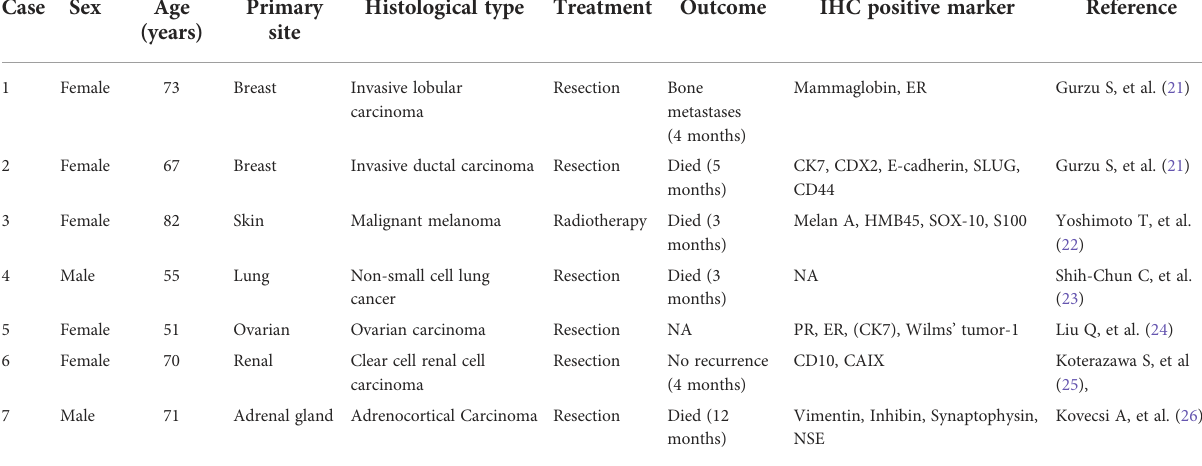
TABLE 2 Rare primary sites of secondary gastric